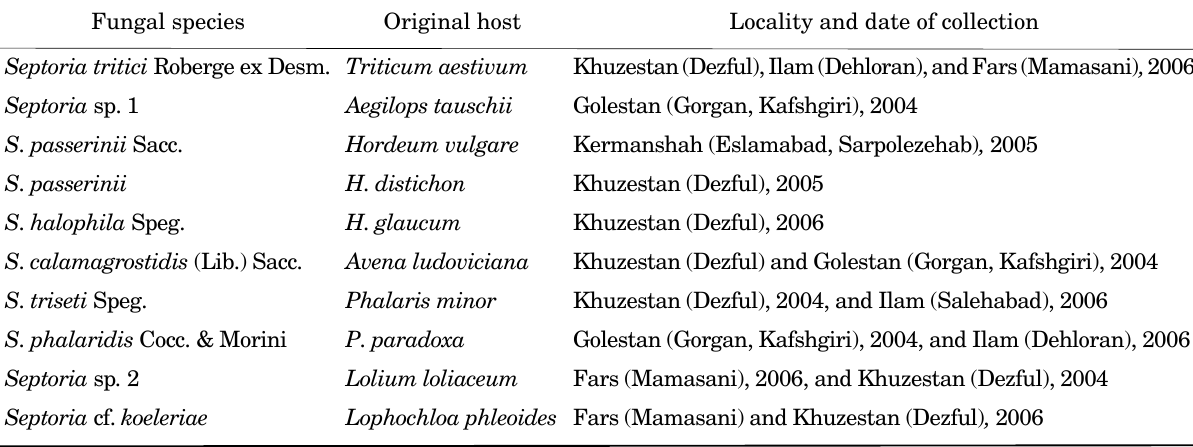
Table 1. Septoria species, host plants, locality and date of collection in four provinces of Iran.